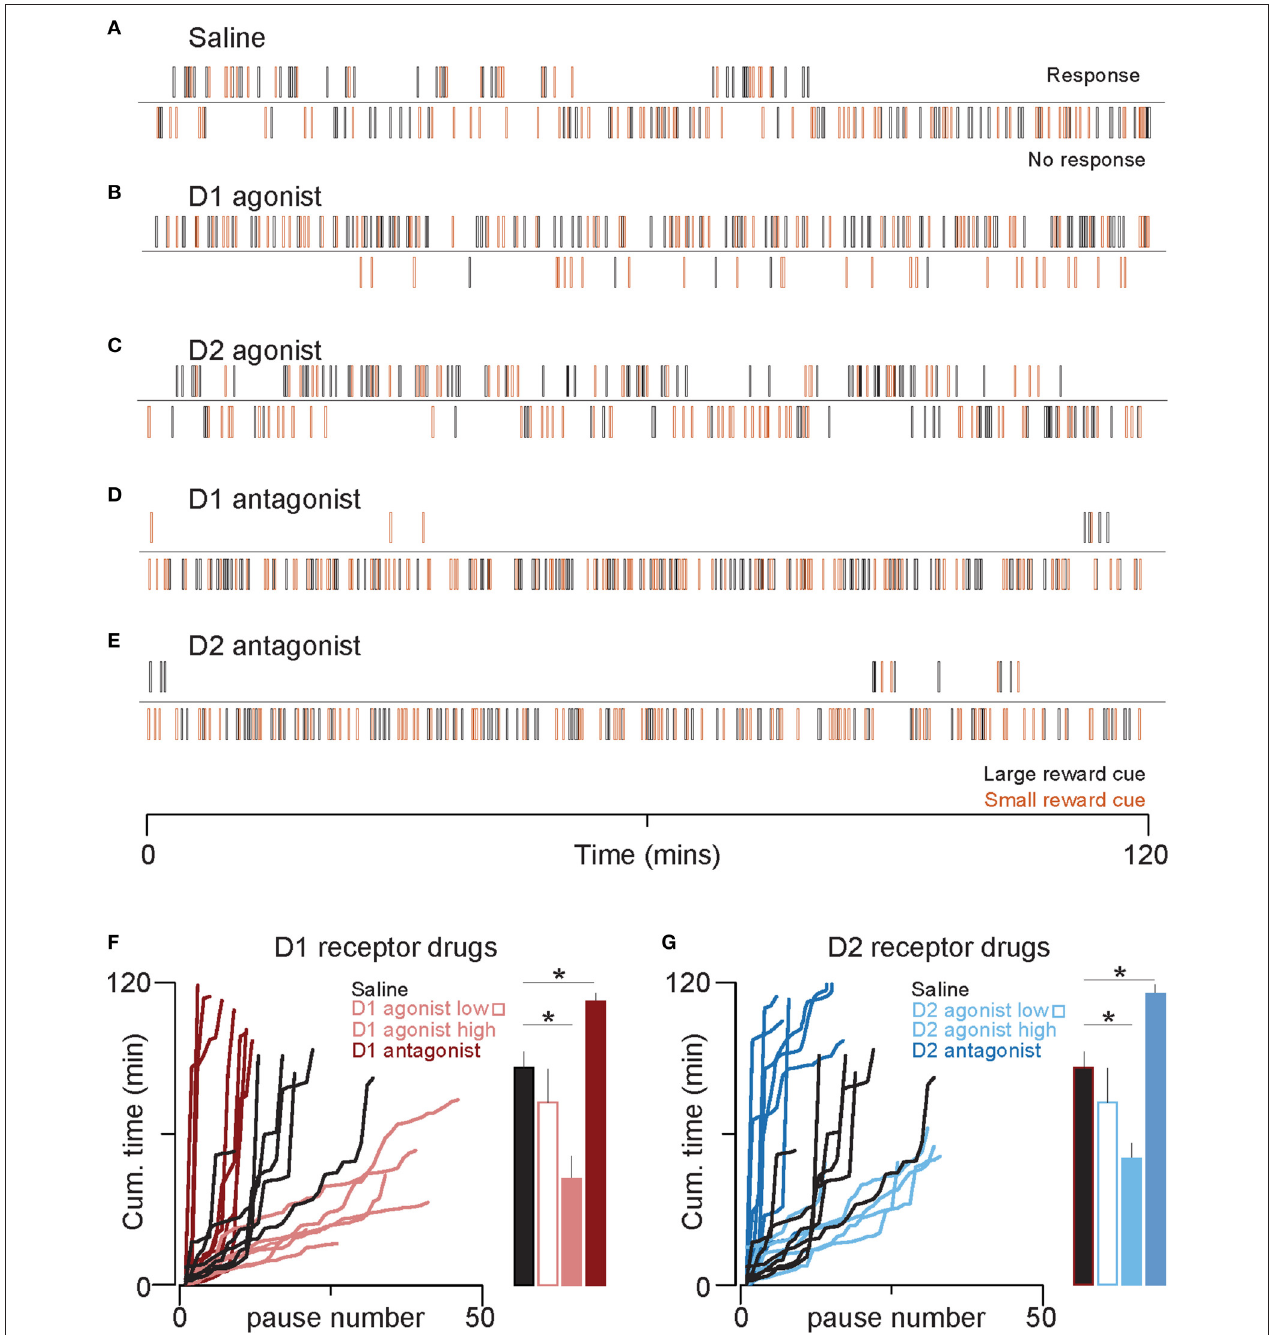
FIGURE 2 | D1 and D2 receptor agonists decrease time spent in the non-responsive state. (A–E) Rasters show five example sessions, one for each drug (high doses only). Each line represents the time at which a cue predicting large (black) or small reward (orange) was presented. The top raster of each pair indicates cues that the animal responded to by entering the receptacle. The bottom raster indicates cues that the animal did not respond to. Note that the length of the non-responsive state is longer toward the end of the session in the control condition (A) , but the non-responsive state is very short or absent in the D1 agonist (B) and D2 agonist (C). (F) The left graph plots cumulative time spent in the non-responsive state against the number of transitions from responsive to non-responsive. Thus, steeper lines indicate long pauses (non-responses to contiguous sequences of cues) interrupted with few responses and shallower lines represent short pauses with frequent responses. Each line is the data from an individual rat. The bar plots on the right show the mean cumulative time spent in a non-responsive state over the entire session for each treatment group. Color conventions are identical to those in Figure 1D . (G) The graphs follow identical conventions to those in (F) , but here for the D2 agonist and antagonist treatments. Color conventions are the same as those in Figure 1E . * p < 0.05.